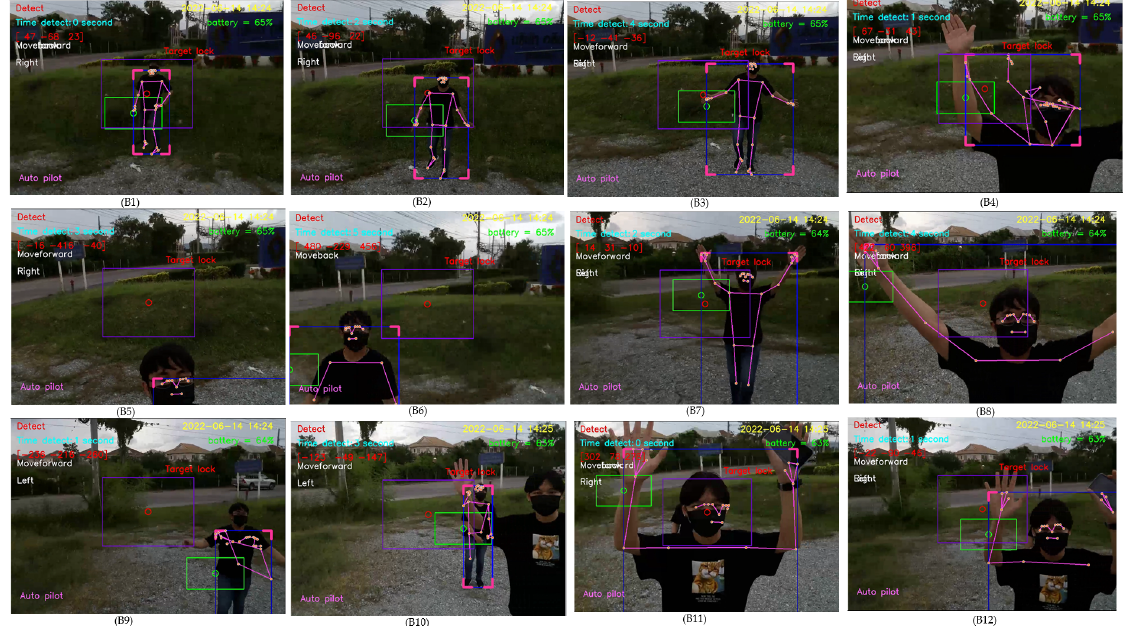
Figure 38. Human detection in the case when a new person comes closer than the first